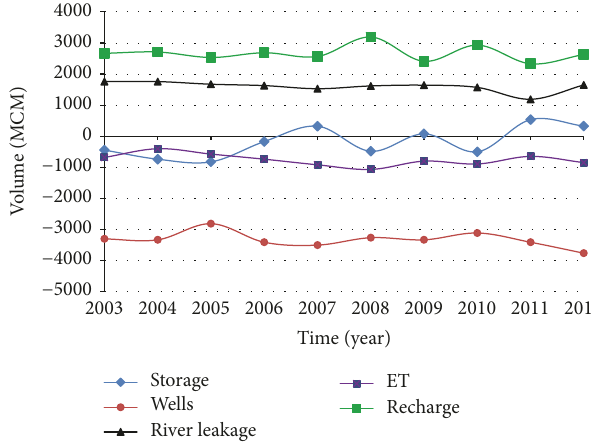
Figure 5: Water balance for the years 2003 to 2012.